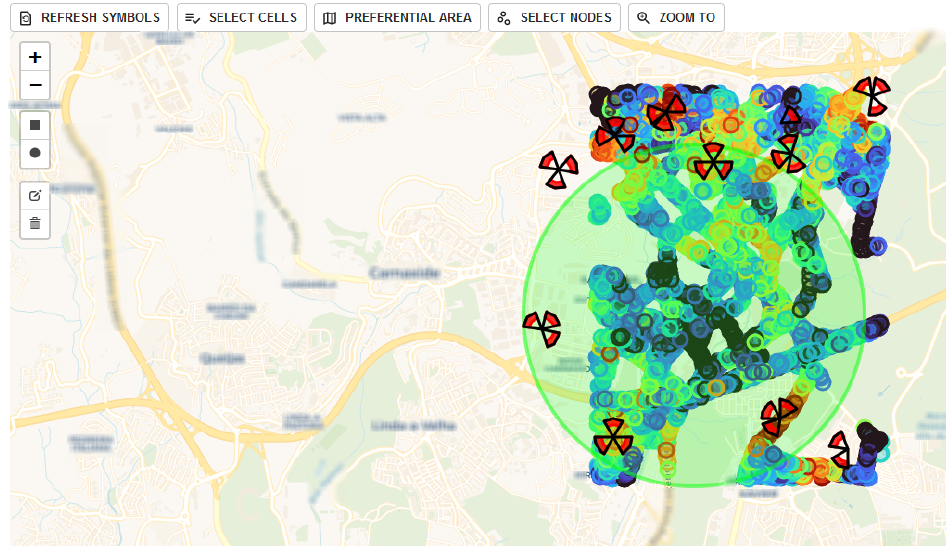
Figure 16. Selection of likely cells with low